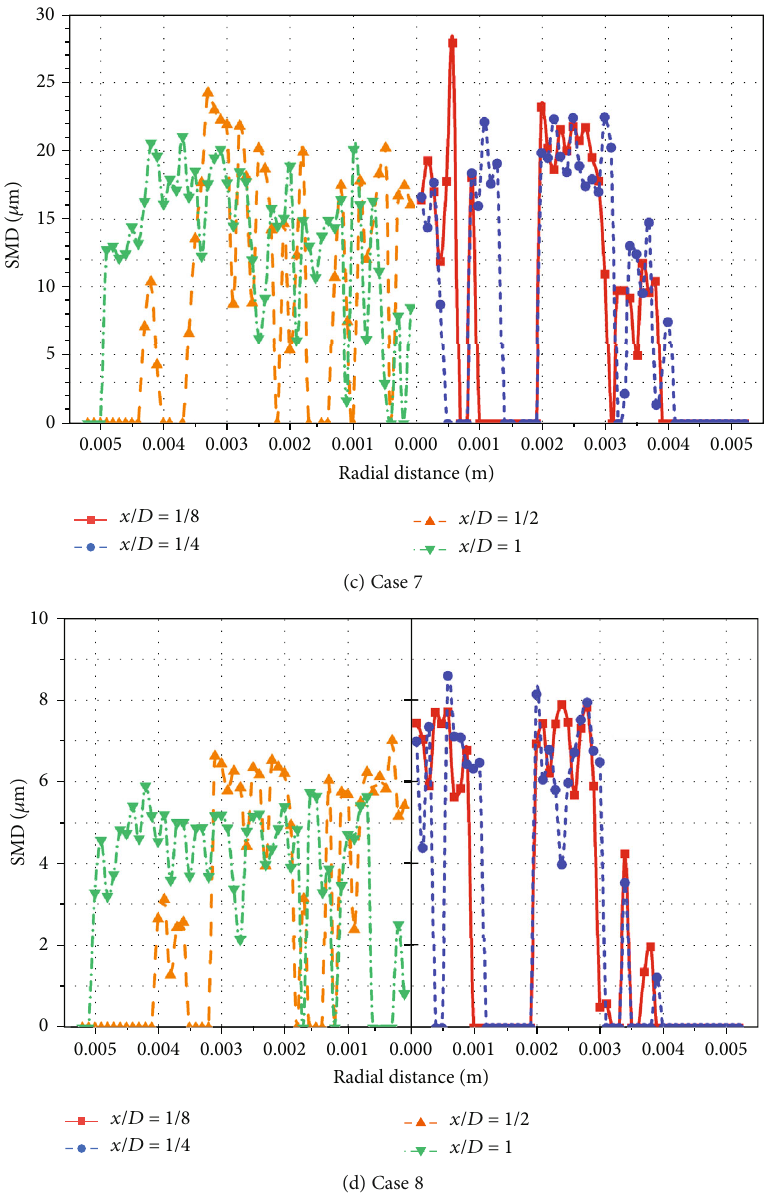
Figure 10: Comparison of the SMD distribution along radial direction in speci fi c case at di ff erent axial